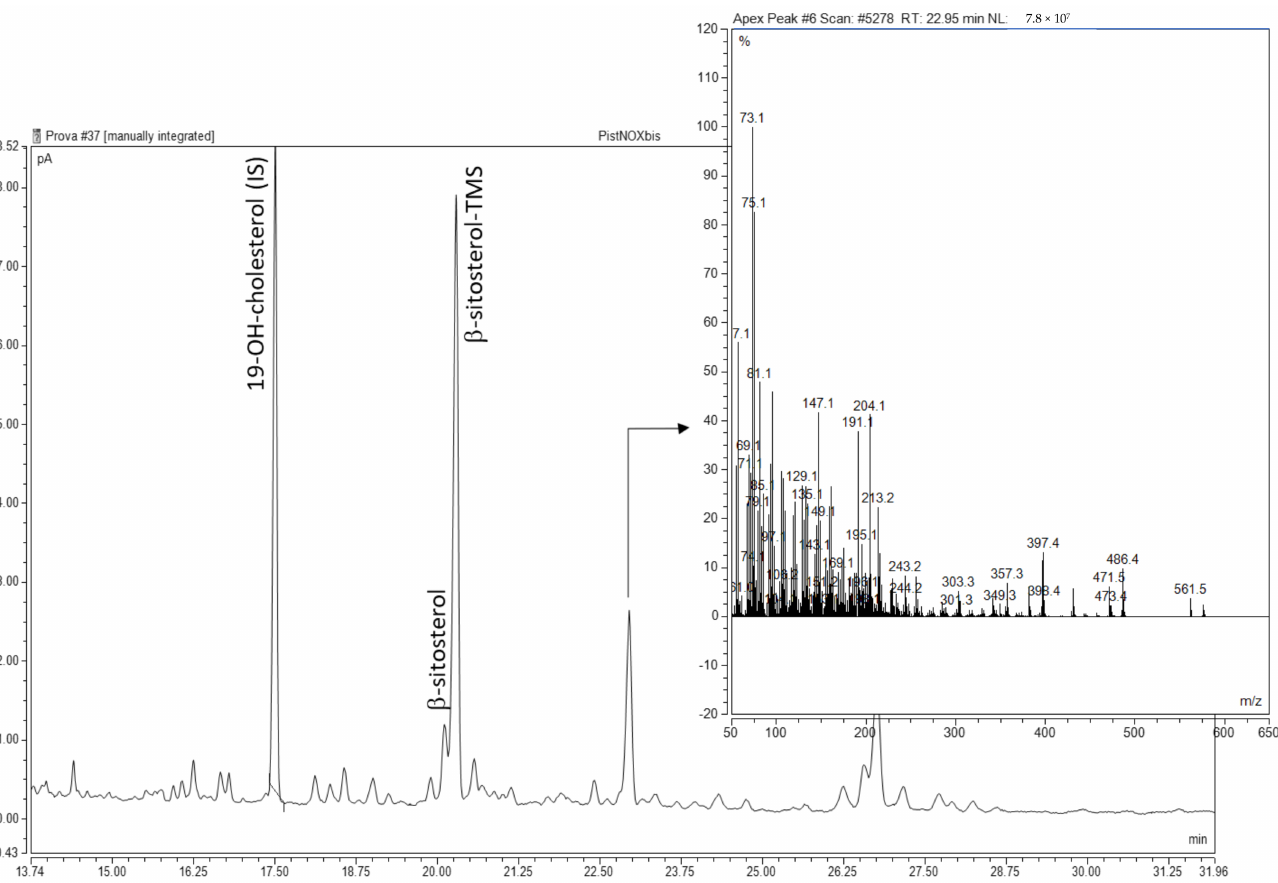
Figure 1. GC-FID chromatogram of the SPE polar fraction of the unsaponifiable matter of pistachio kernel oil and mass spectrum of the hypothesized POPs